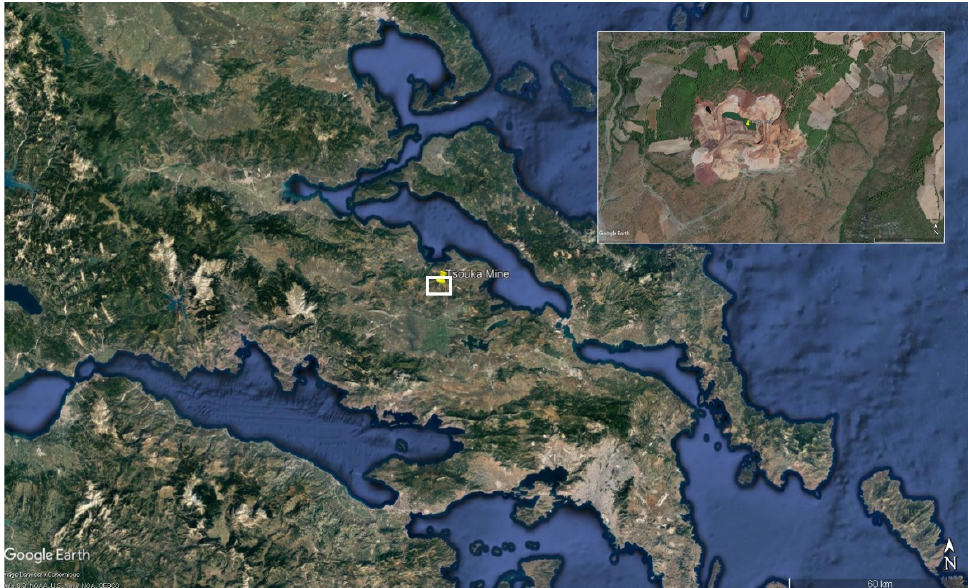
Figure 1. Location of the Tsouka deposit in central